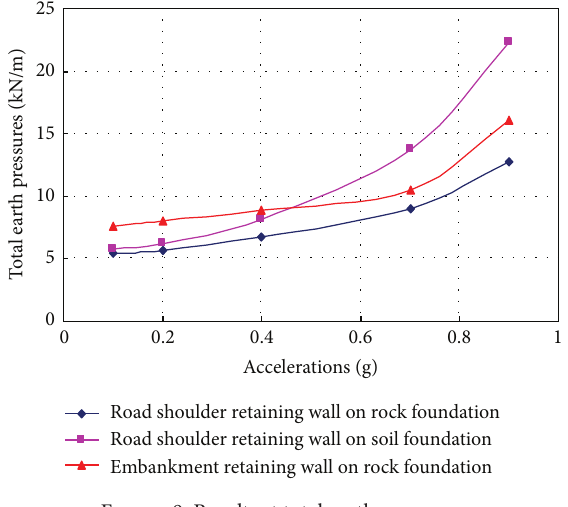
Figure 9: Resultant total earth pressures.